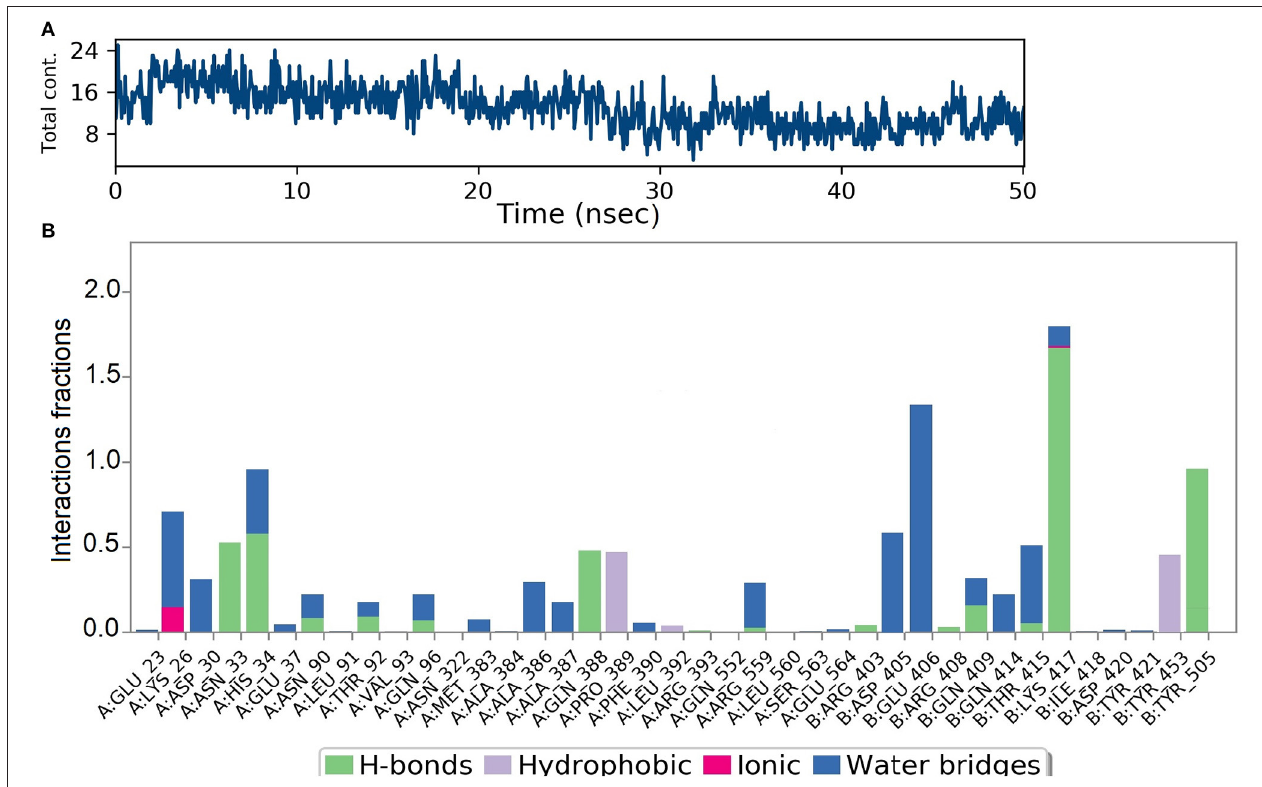
FIGURE 7 | Results of MD of NZO-SARS-CoV-2 S-protein-ACE-2 complex. (A) Timeline of the total contacts between NZO and SARS-CoV-2 S-protein-ACE-2 interface. (B) Stacked bar chart represents the normalized interactions throughout the trajectory. Y -axis represents the % of simulation time the specific interaction was maintained. Asn33 of ACE-2 receptor, chain A maintained hydrogen bond contact for 50% of the simulation time. Lys417 of the S protein, chain B, value above 1 indicates that it maintained multiple hydrogen bond contacts with the ligand throughout the simulation